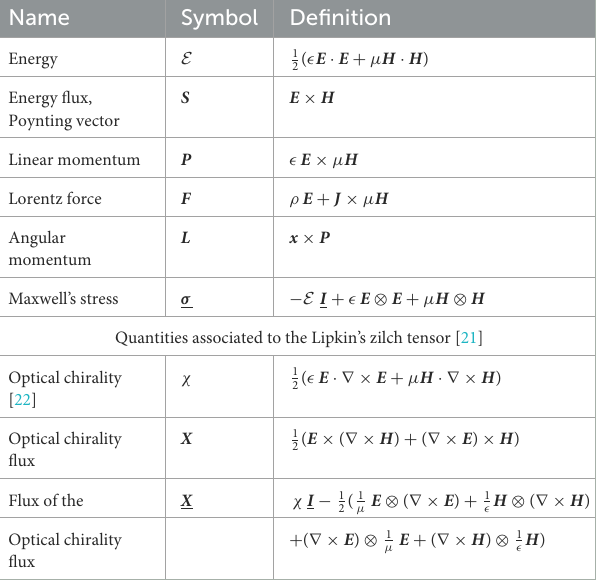
TABLE 3 Glossary of electromagnetic quantities, see Sánchez et al. [3]. TABLE 4 Conservation laws for the (scalar or vectorial) electromagnetic quantity η